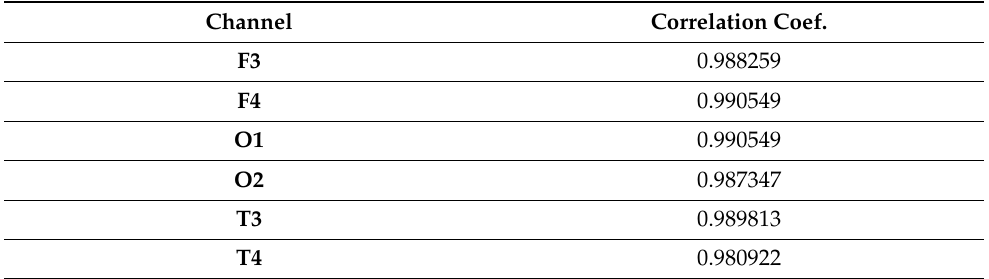
Table 1. Example of the correlation coefficients of the regression for the computation of the Hurst parameter in the six electrodes (F3, F4, O1, O2, T3,